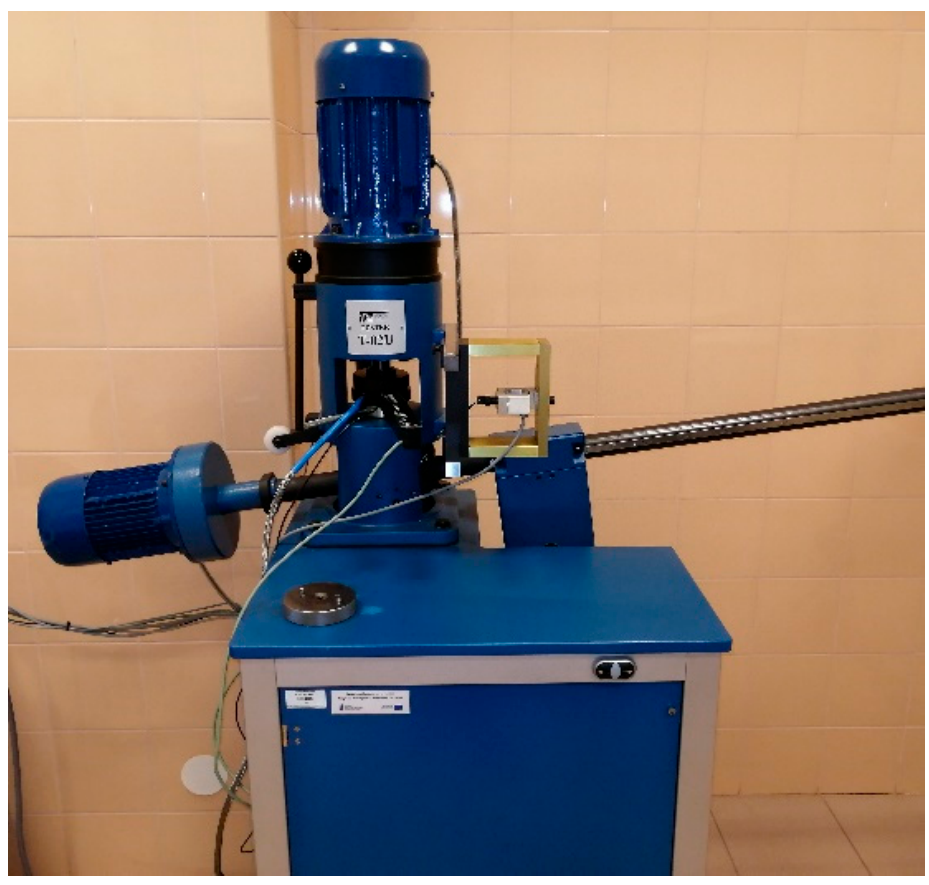
Figure 1. The four-ball machine T-02U used to determine the lubricity tests. The mechanical part of the machine (testing machine) consists of the body, drive unit, tribosystem loading unit, ball chuck, and base (Figure 2) [53]. Figure 3 shows the tribosystem, which consists of three stationary balls fixed in the ball pot that are pressed at the required load against the top ball. The top ball is fixed in the ball chuck, rotating at the defined